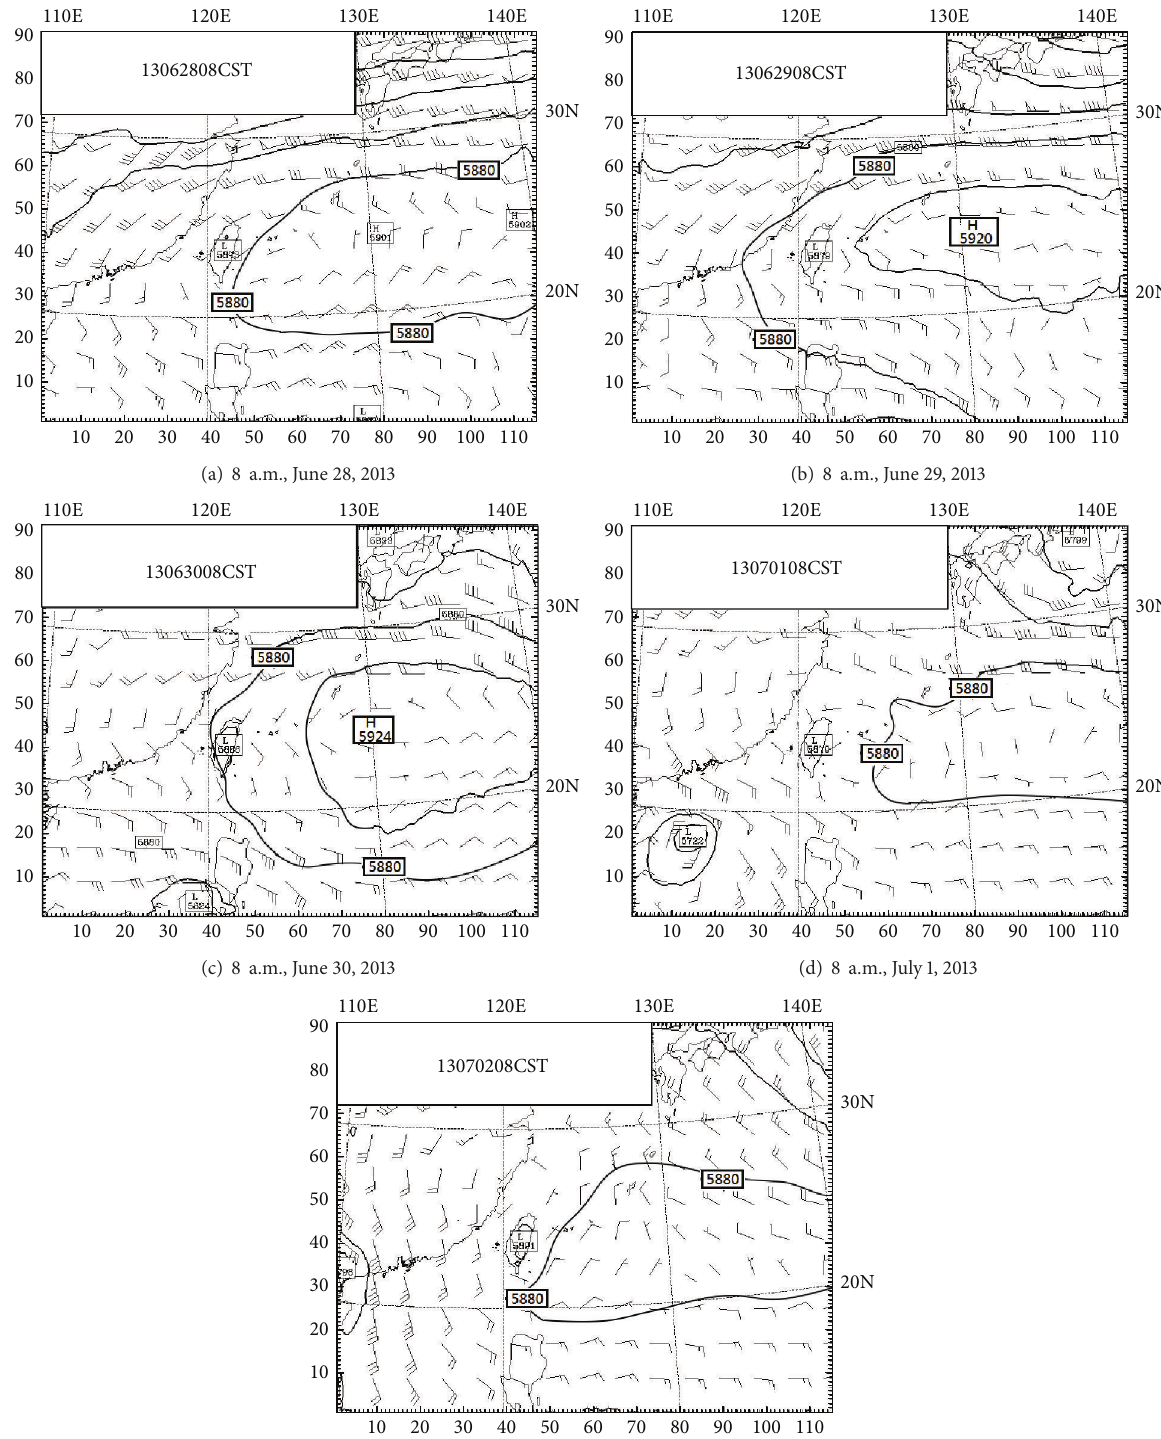
Figure 8: Simulated geopotential height (gpm) and horizontal wind vectors (m/s) at the 500 hpa model